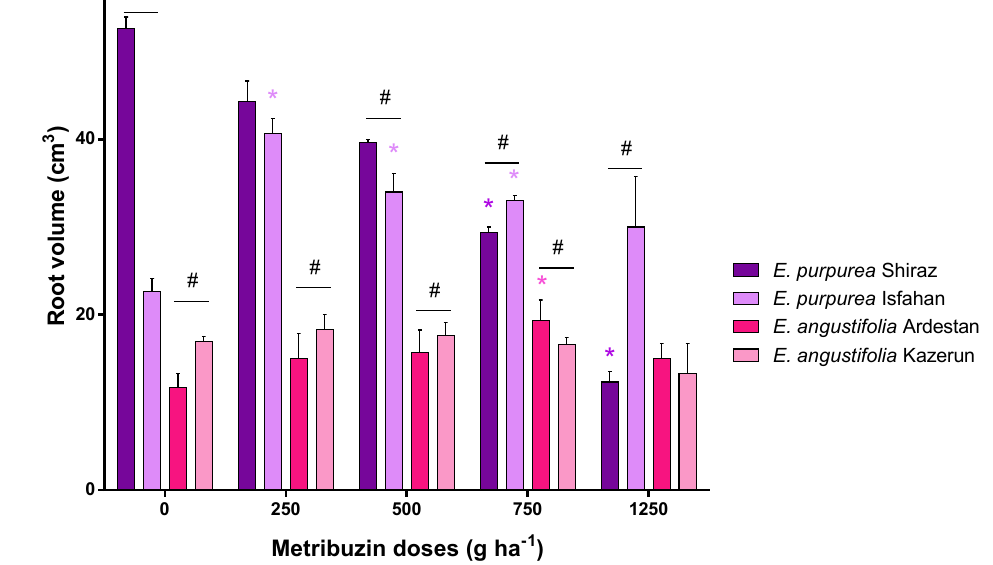
Figure 5. Effect of different metribuzin doses on root volume of Echinacea purpurea and Echinacea angustifolia species. Data are shown as the mean ± SEM, and ordinary two-way ANOVA followed by Dunnett’s multiple comparisons test was used for statistical significance; * p < 0.005 vs. control (0 g ha − 1 metribuzin). Significant differences between Echinacea cultivars are indicated with #.